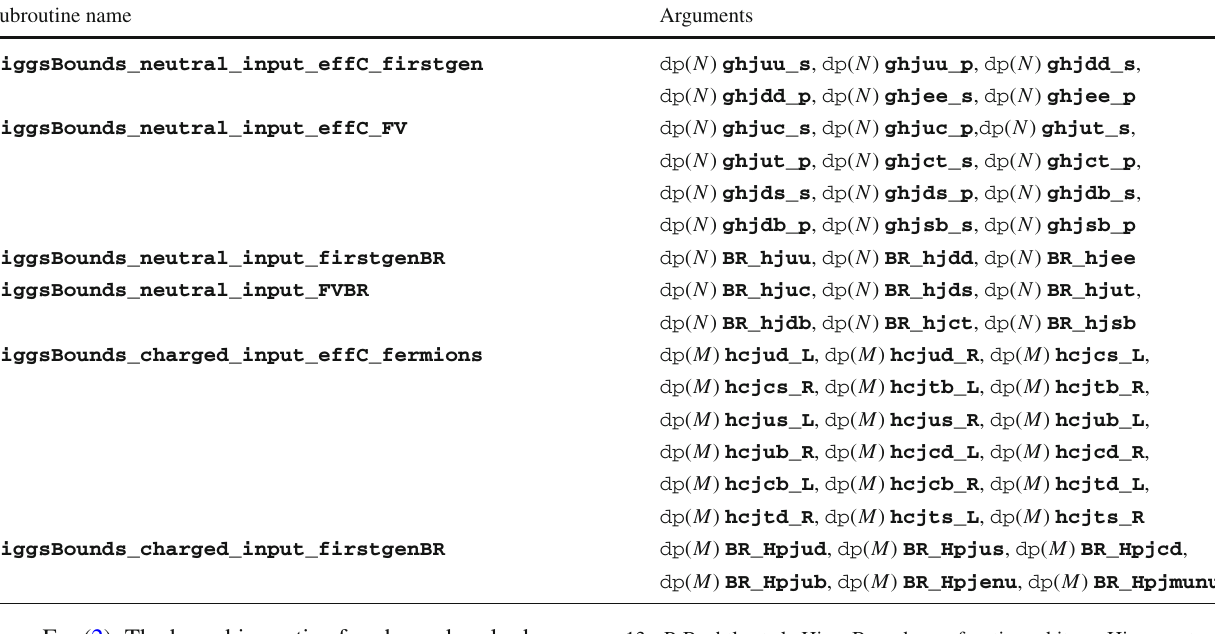
Table 11 Listing of all new HiggsBounds input subroutines. The subroutine arguments (right column) are specified by their default name and their Fortran data type ( gray font ) as double precision ( dp ) with